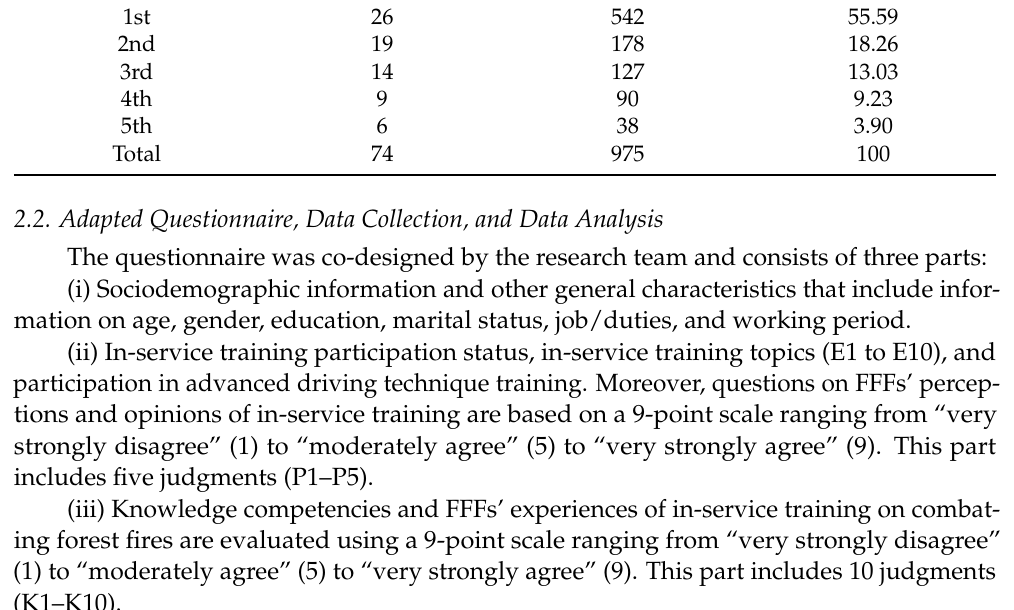
Table 2. Distribution of FFFs who participated in the study by FED and FSECs. FSECs Number of FEDs Number of